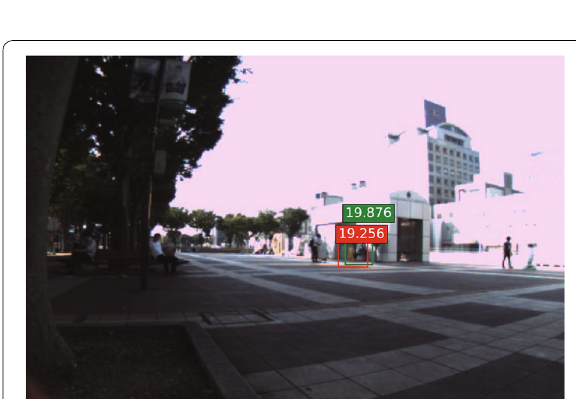
Fig. 20 Examples of estimated distance for the far-view of the target object in Tsukuba Challenge. The ground truth distance and estimated distance are written in green and red boxes respectively. The unit is in meter